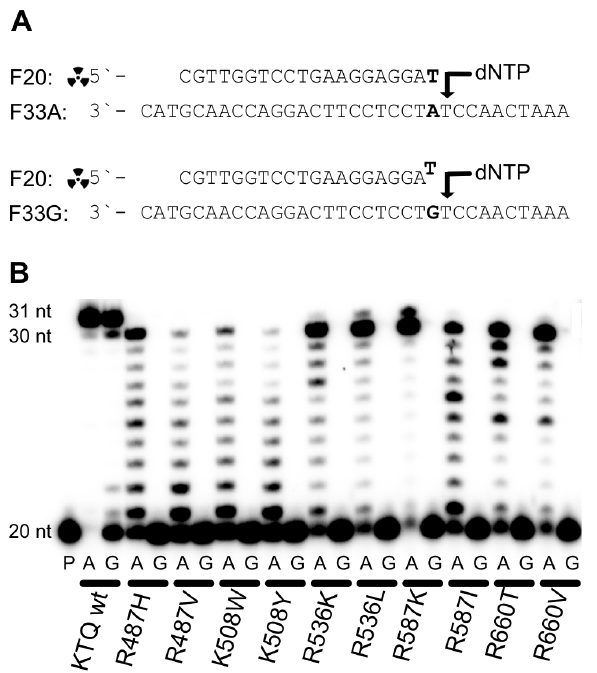
Figure 2. Primer extension experiments with KlenTaq wild-type and mutants. A) Primer and template sequence. The radioactively labelled primer is either 3’ matched or mismatched depending on the template. B) PAGE of primer extension, P = primer, A = match case template, G = mismatch case template. Mutants and KlenTaq wild-type as indicated.